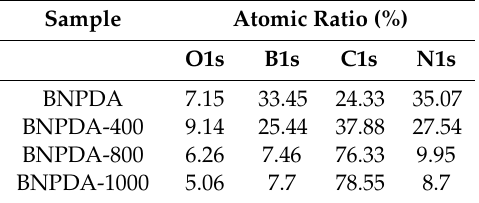
Table 1. Quantitative comparison of elements detected from XPS spectra (At%).